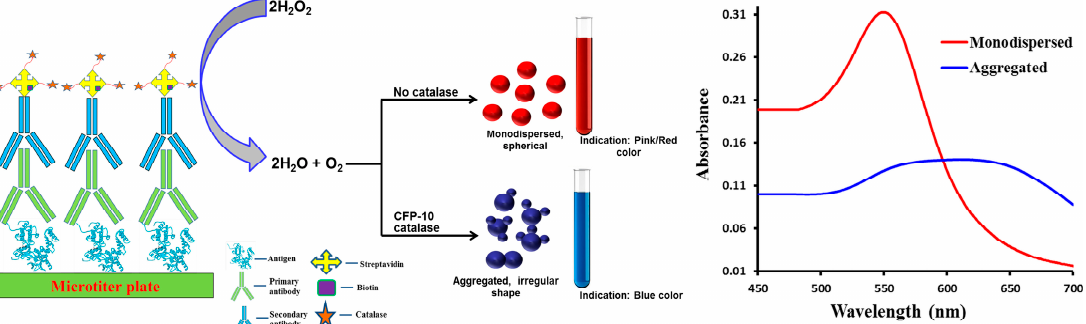
Figure 1. Schematic representation of the principle involved for the naked eye TB detection and the corresponding absorption spectra for the monodispersed and aggregated particles. With the use of this technique, the formation of pink/red colored solution means that the GNPs are monodispersed, no catalytic reaction and so no M. tuberculosis . Similarly, formation of blue colored solution indicates the formation of aggregated GNPs, and a CFP-10 mediated catalytic reaction which supports the presence of M. tuberculosis .